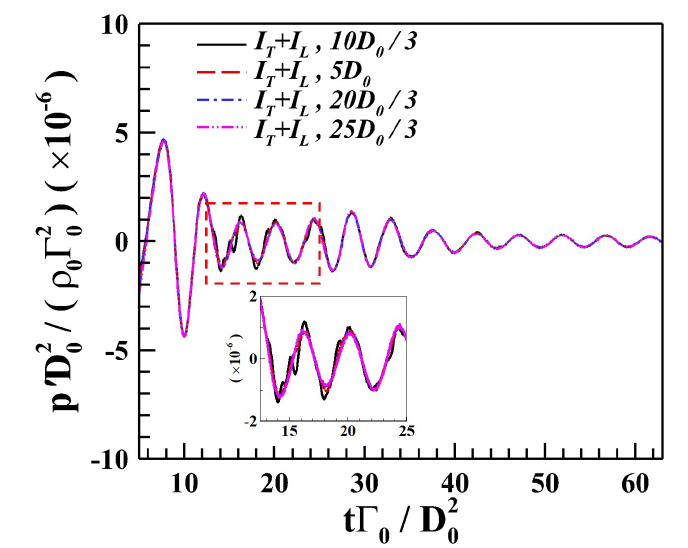
Figure 10. Acoustic pressure calculated by summing Equations (3) and (4) without filtering the spurious mass flux at the observer 1250 D 0